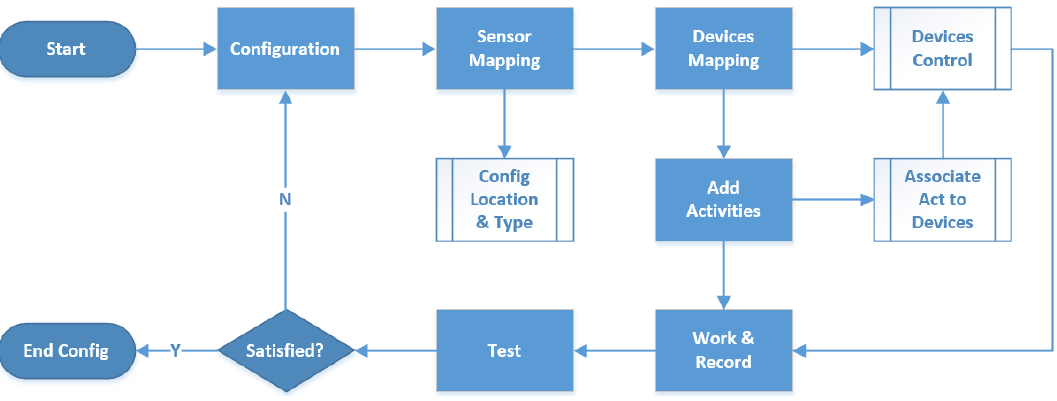
Figure 13. Flow chart of configuration module.